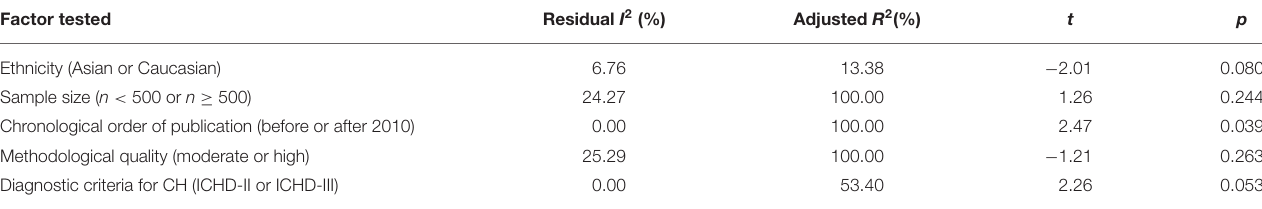
TABLE 3 | Meta-regression